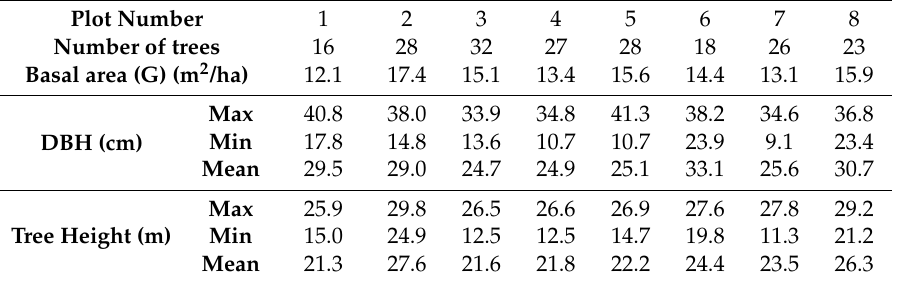
Table 4. Summary tree attributes by plot ( n = 8).